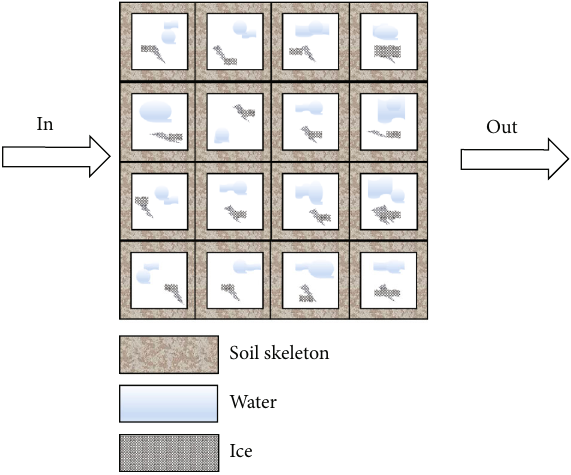
Figure 9: Integrated REV model.